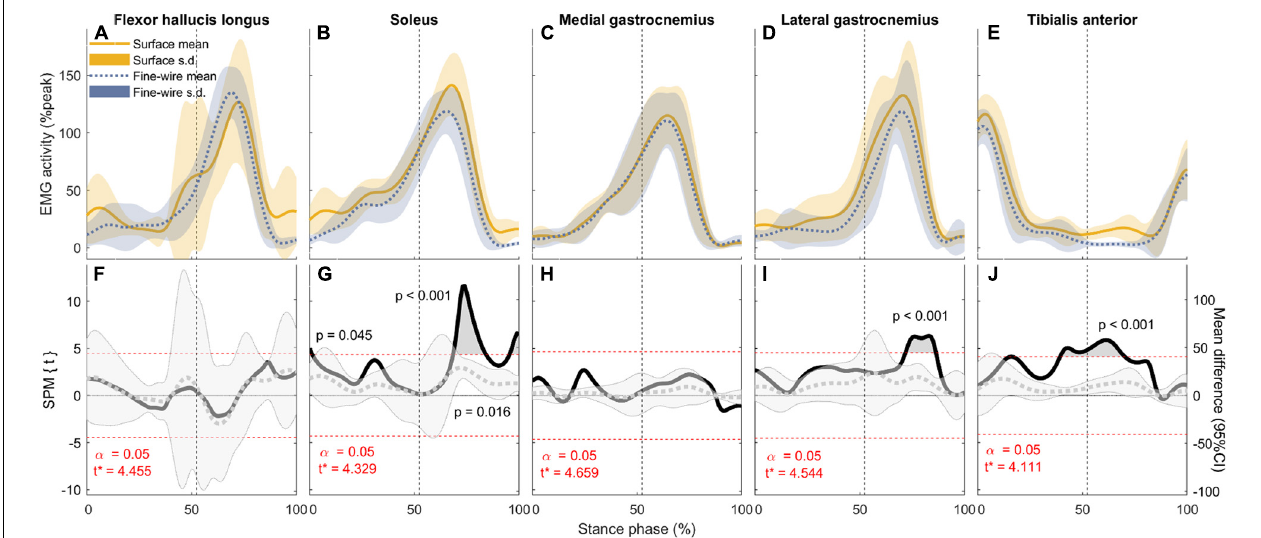
FIGURE 5 | Electromyography (EMG) activity (mean and standard deviation) of each muscle ( A–E : normalised to peak activity in preferred speed walking, %peak) and the corresponding comparisons between surface and intramuscular EMG recordings (F–J) in the stance phase of fast walking (1.84 ± 0.23 m s − 1 ). Vertical dotted lines represent the beginning of push-off. Panels (F–J) SPM{ t } statistics for two-tailed t -tests (solid black lines, left y -axis), and mean difference with 95% confidence intervals (grey dotted lines with shaded areas). Dashed red lines are critical thresholds ( t ∗ ) calculated for α significance level defining supra-threshold clusters for SPM{ t } trajectories. P -values were calculated for each supra-threshold cluster.